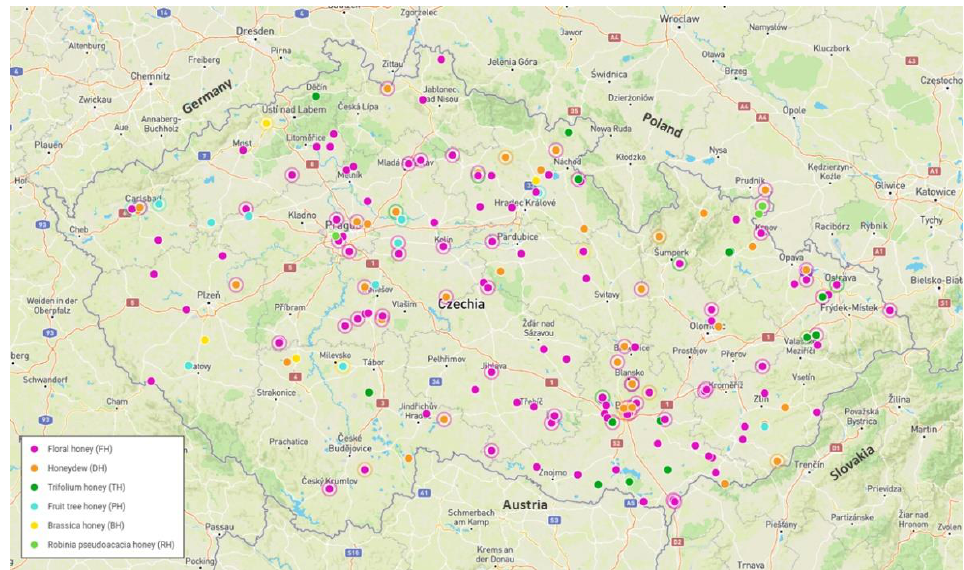
Figure 1. Sampling sites according to honey classification. Note: a double point on the map means multiple sampling in the given location.